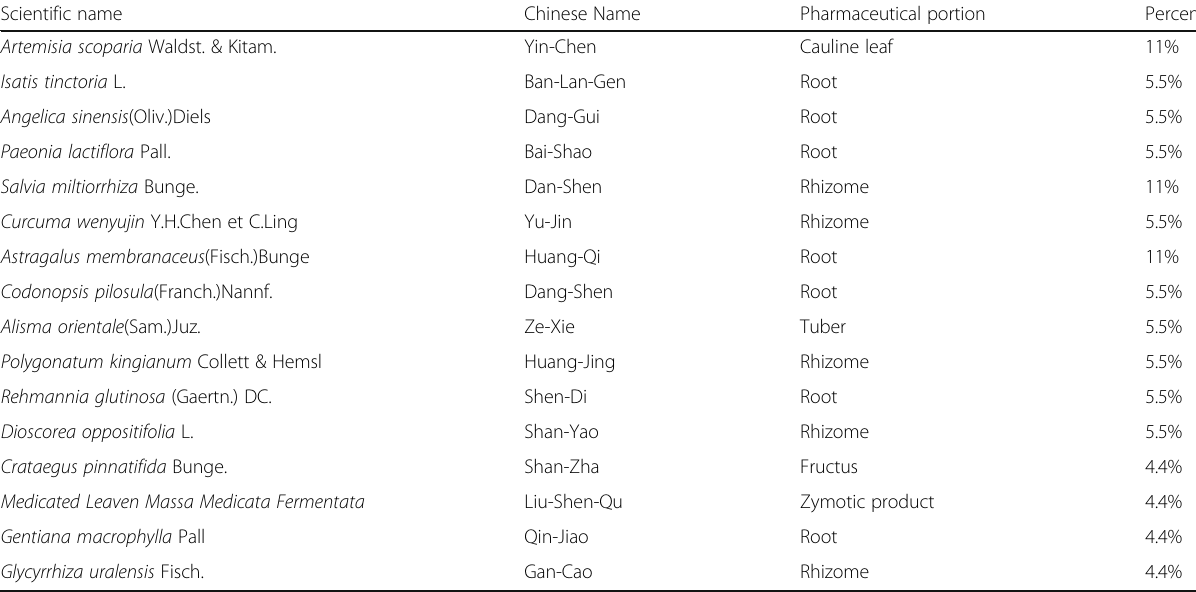
Table 1 The composition of Qianggan